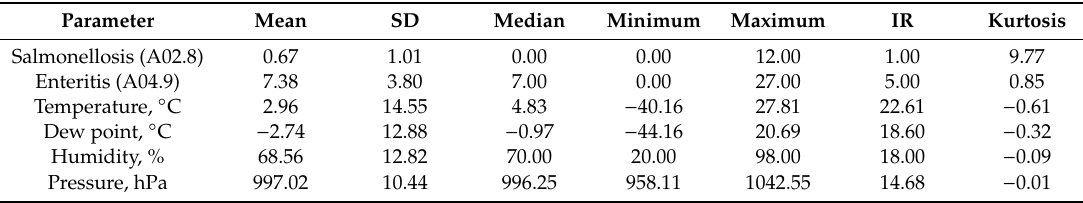
Table 1. Statistical characteristics for daily values of health outcomes and weather